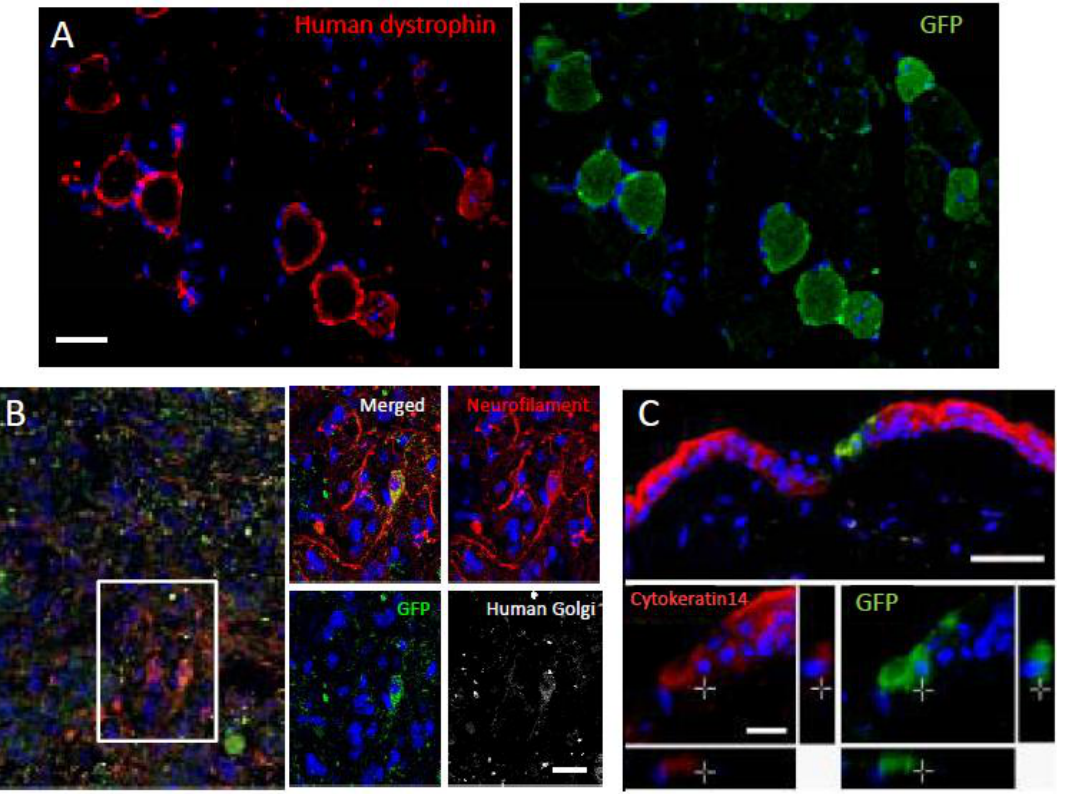
Figure 5. Differentiation and repair effects of Muse